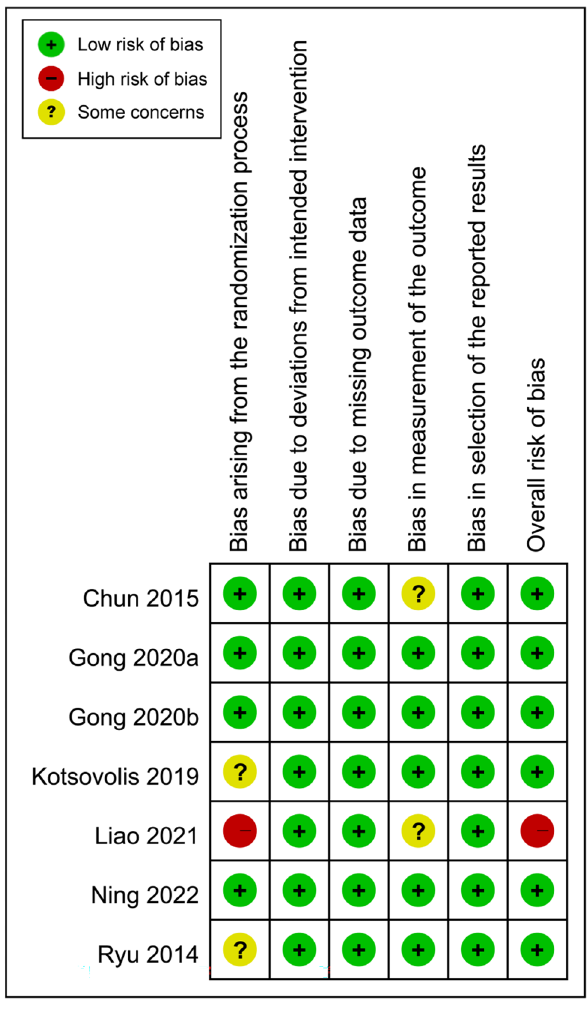
Figure 2. Risks of bias of the included